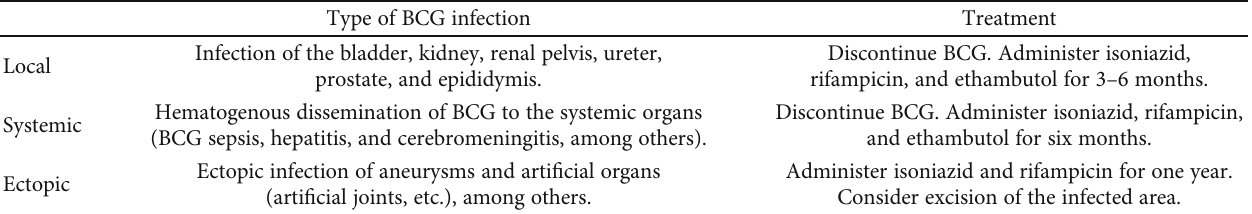
Table 1: Types of Bacillus Calmette-Guérin infections and treatments. Type of BCG infection